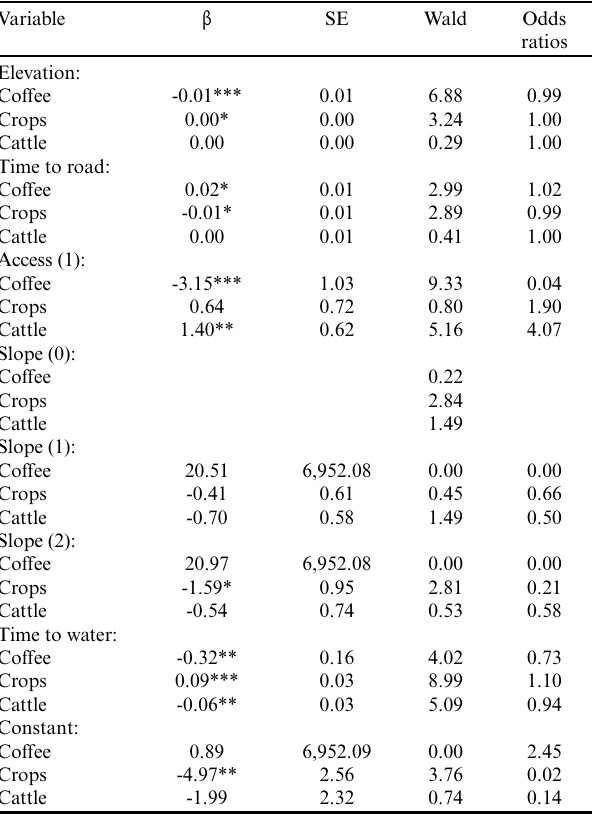
Table 5 . Binary logistic regression predicting the likelihood of growing coffee, crops, and cattle rearing. Note: slope 0 = flat, 1 = medium, and 2 = steep; *** α = 0.01, ** α = 0.05, and * α =